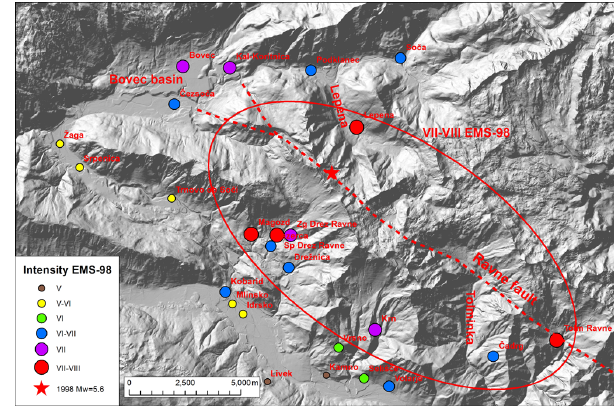
Fig. 1. Location map of the study area with epicentre of 12 April 1998 earthquake.